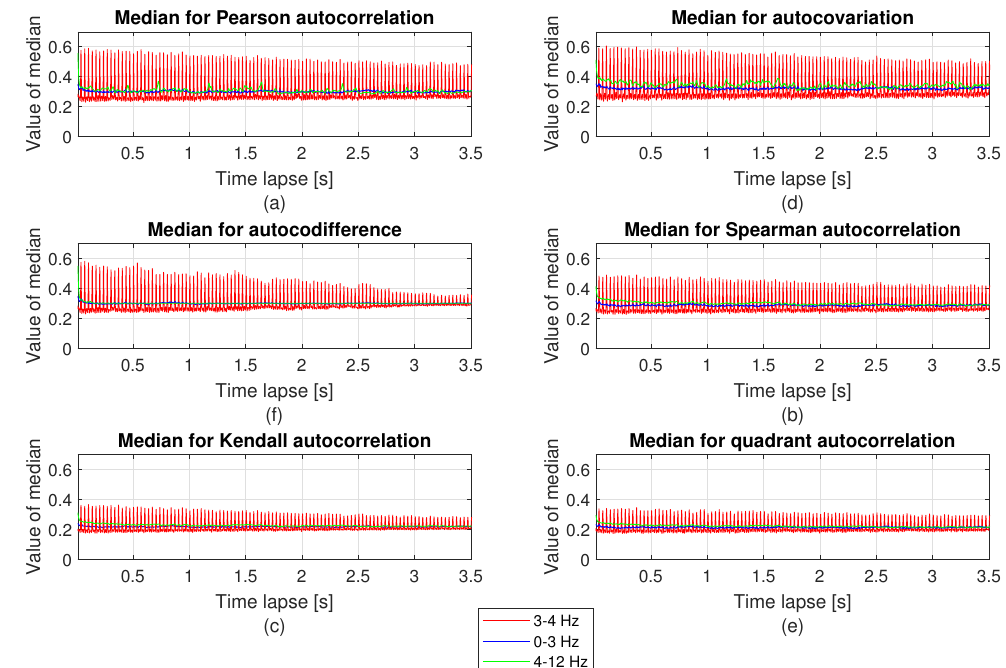
Figure 16. Comparison of medians for different frequency bands: 0–3 kHZ (Gaussian noise), 3–4 kHz (informative frequency band), 4–12 kHz (heavy-tailed noise), in the case of different measures of dependence: ( a ) Pearson autocorrelation, ( b ) auto- covariation, ( c ) autocodifference, ( d ) Spearman autocorrelation, ( e ) Kendall autocorrelation, ( f ) Quadrant autocorrelation.